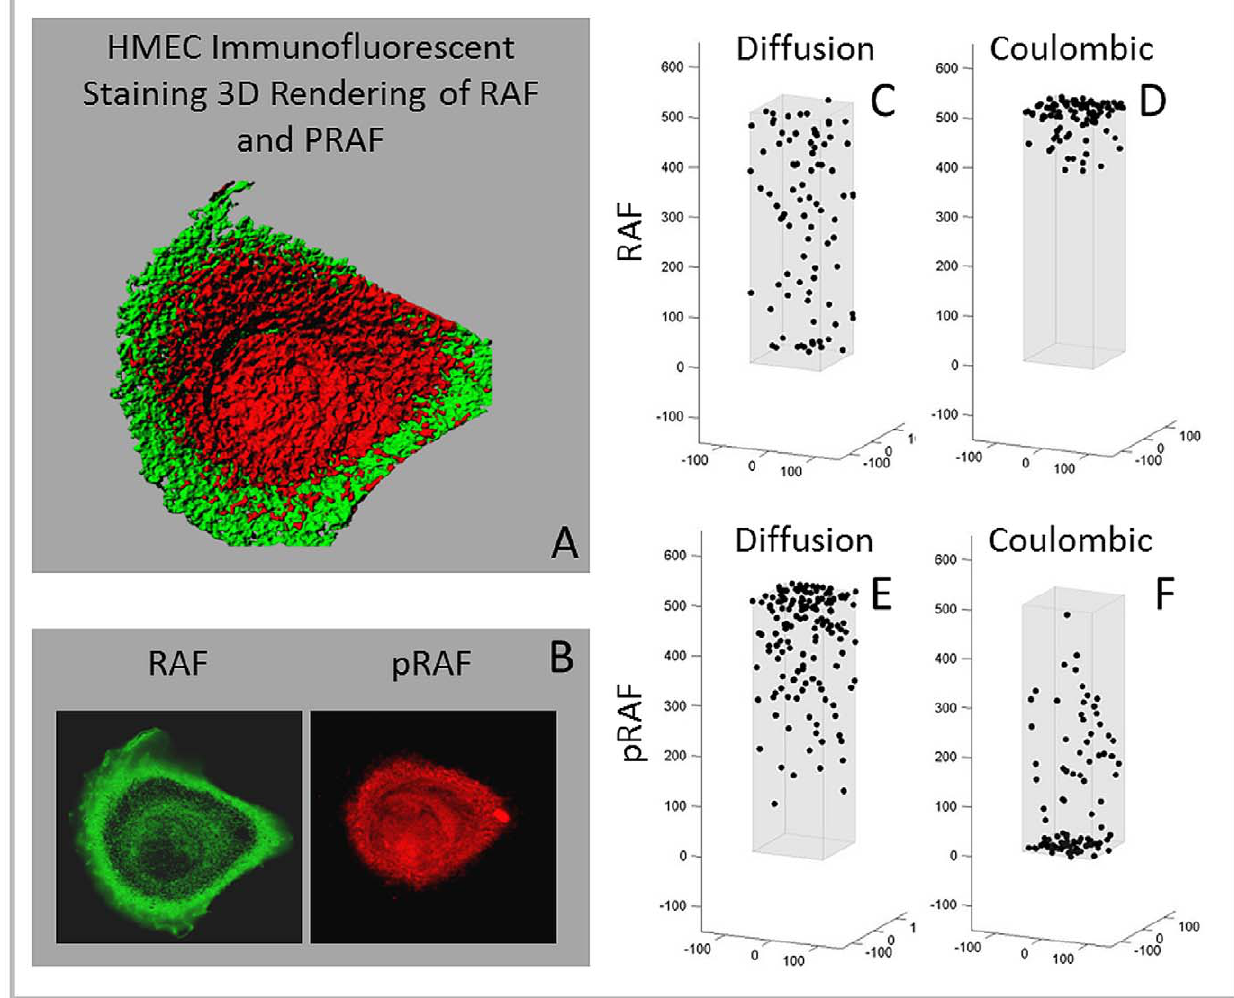
Figure 7. Predicted and measured steady state distribution of RAF and pRAF under typical culture condition with continuous ligand binding of EGFR on the cell membrane. The left panels demonstrate typical pRAF and RAF distribution in cultured HMEK cells. A) An iso- rendered distribution of RAF (green) and pRAF (red) with B) the photomicrograph demonstrating RAF clustered around the CM and pRAF clustered around the NM, as predicted by the IEM simulations. In the right panels, computer simulations demonstrate that if protein movement is by diffusion alone, pRAF will exhibit a concentration gradient with highest levels near the CM where it is generated by interactions with RAS and lowest levels near the nucleus. RAF will be widely dispersed. In the IEM simulations, pRAF will, due to its negative charge, concentrate near the nucleus while RAF (with an IEP of 9.2) will cluster near the CM.